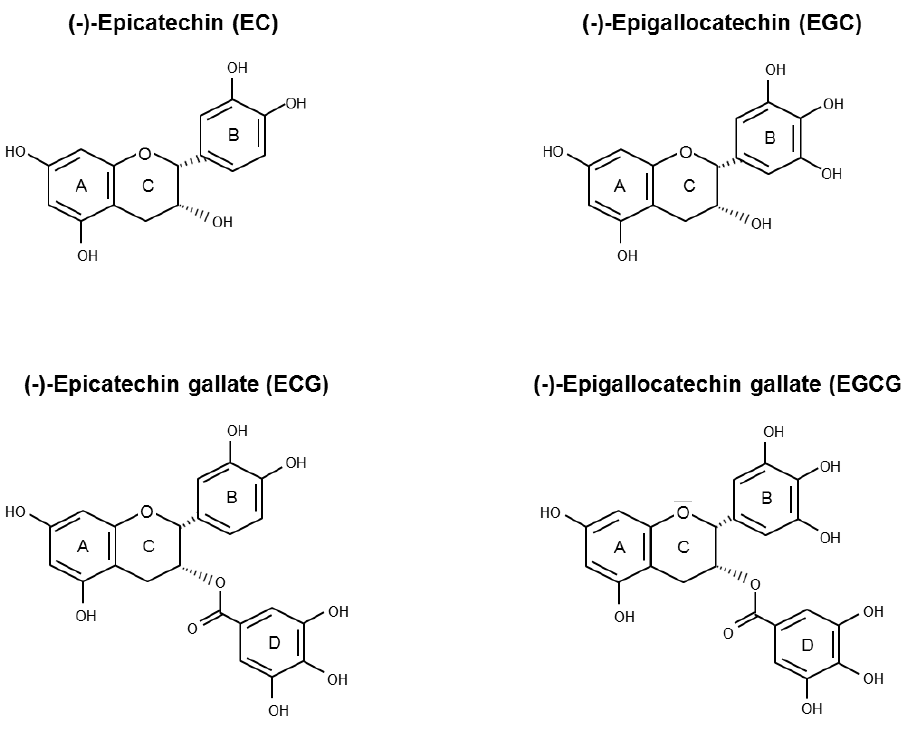
Figure 1. Chemical structure of the four main green tea catechins (GTCs): ( − )-epicatechin (EC), ( − )-epigallocatechin (EGC), ( − )-epicatechin gallate (ECG), and ( − )-epigallocatechin gallate (EGCG). EGCG accounts for about 40% of the total catechin content in green tea leaves and is the focus of much of the research on the health beneficial properties of green tea and green tea derived